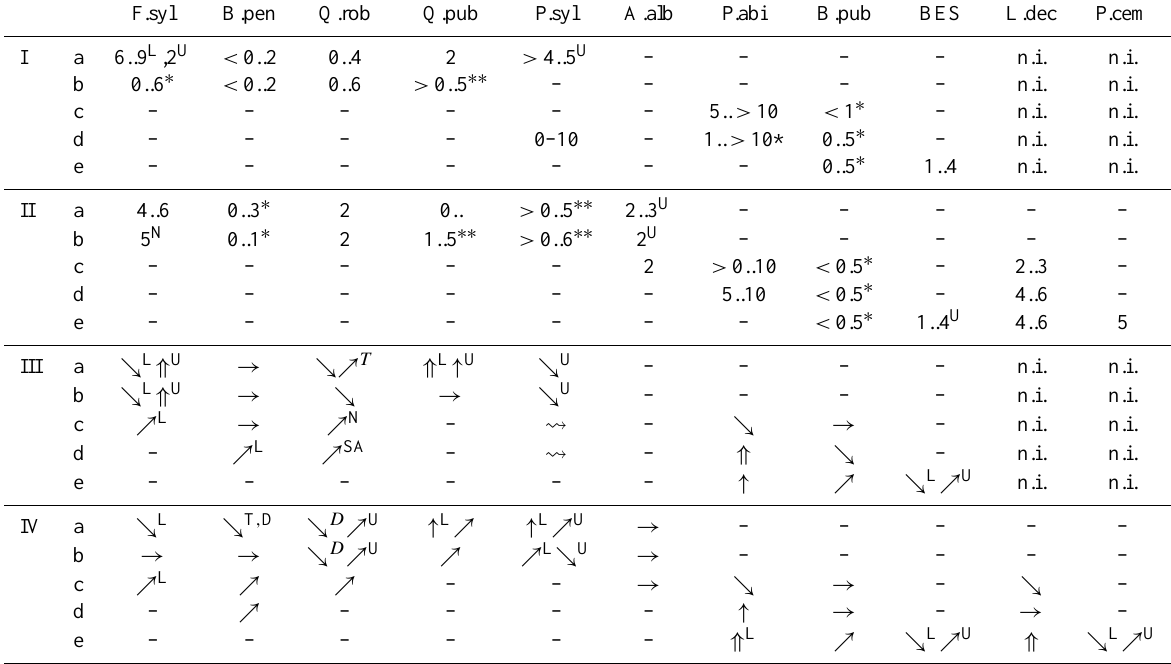
Table 3. Simulation results of selected species for the different regions. Units in kgC m − 2 . I: standard parameter set results for 2000; II: adjusted parameter set results for 2000; III: development of standard parameter set results until 2100; IV: development of adjusted parameter set results until 2100; a: Central Plateau and low sites in the Ticino; b: Alpine valley bottoms (submontane/colline); c: lower montane vegetation zone of Jura, Prealps and Alps; d: upper montane vegetation zone; e: subalpine vegetation zones; n.i.: not implemented; –: species did not establish or only had a very small biomass; N: none if too dry; *: strongly increases with water availability; **: strongly decreases with water availability; U: on upper stands; L: on lower stands; D: on dry sites; T: only Ticino; SA: south Alps; ⇑ : increase higher